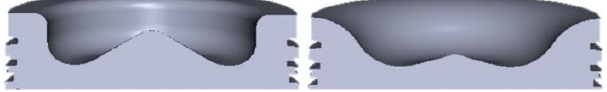
Fig. 16. Potential of piston combustion chamber geometries (reproduced from [22]) Conceptions of bowl piston geometry for RCCI engines